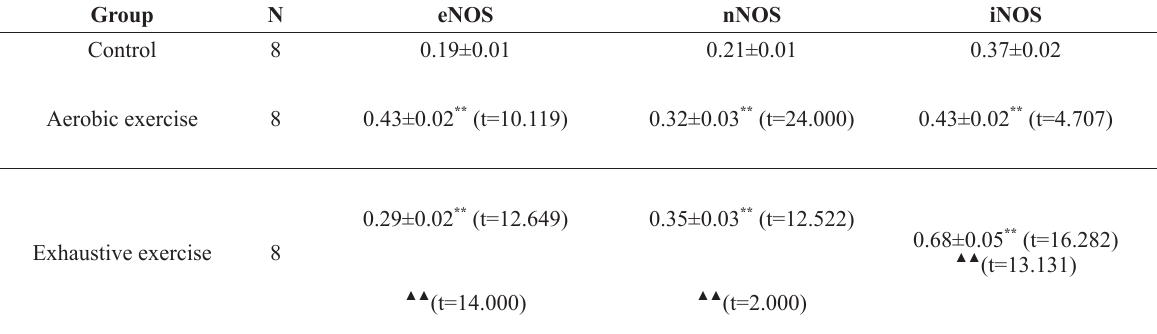
Changes in NOS gene expression in brain tissue of each group (Mean ± standard